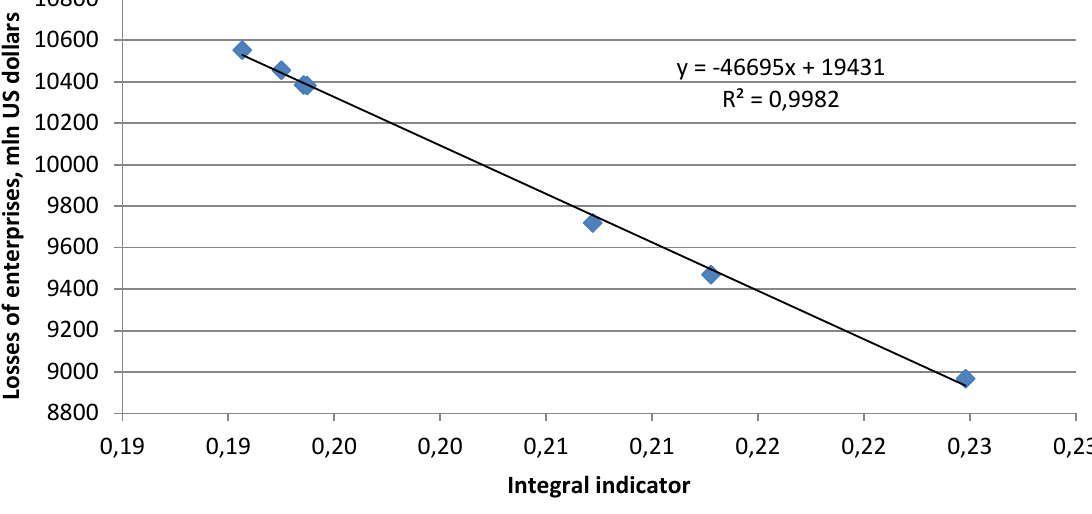
Figure 8. Relationship between the level of business environment security and the volume of enterprise